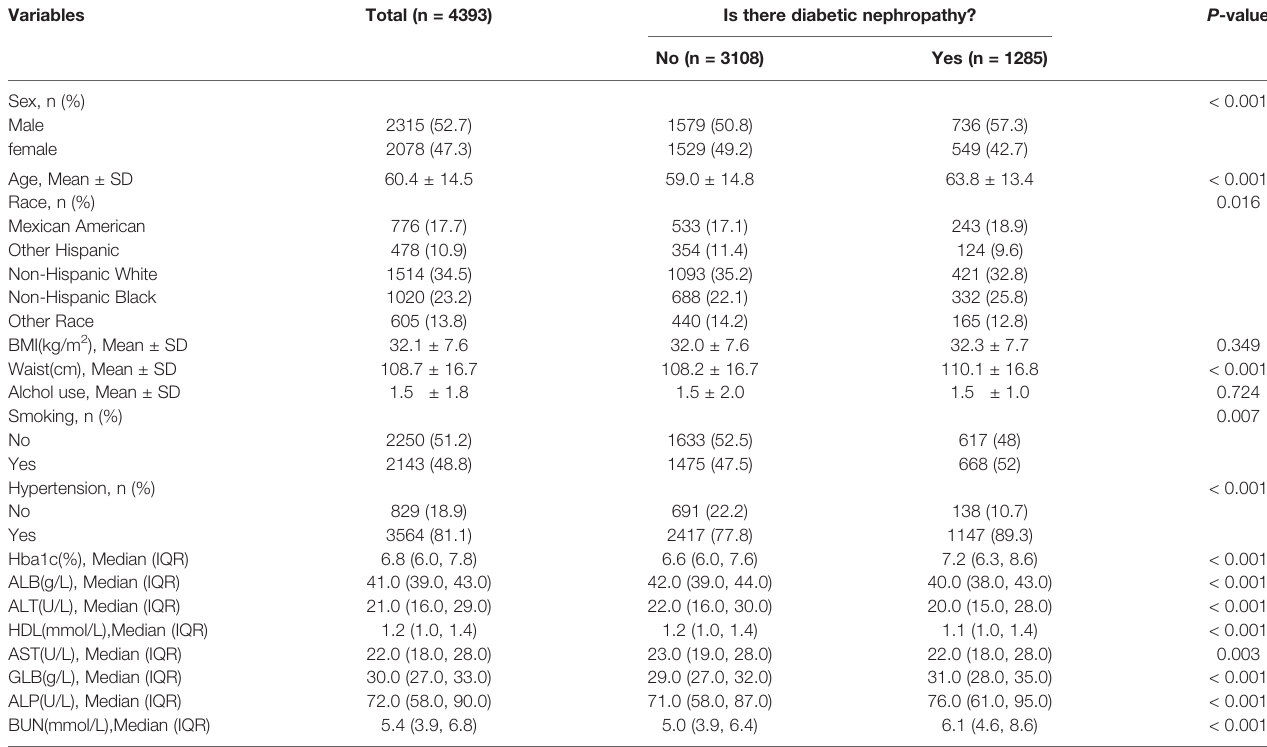
TABLE 1 | Demographic characteristics describe whether diabetic nephropathy occurs. Variables Total (n = 4393) Is there diabetic